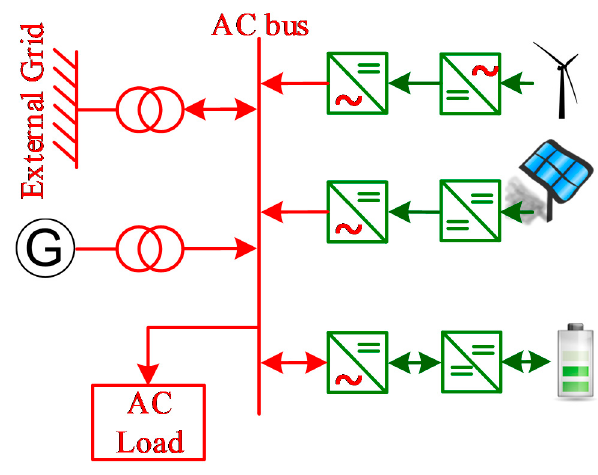
Figure 6. AC architecture for smart grids.